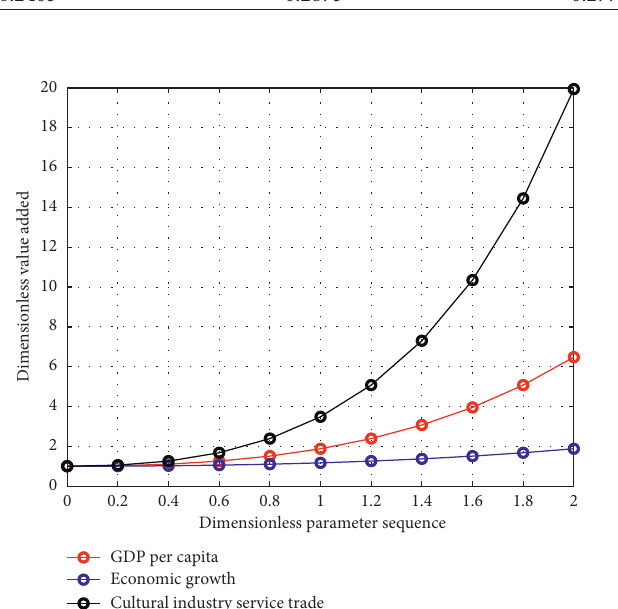
Figure 4: The change trend of economic growth and trade in services of cultural industry under grey correlation degree